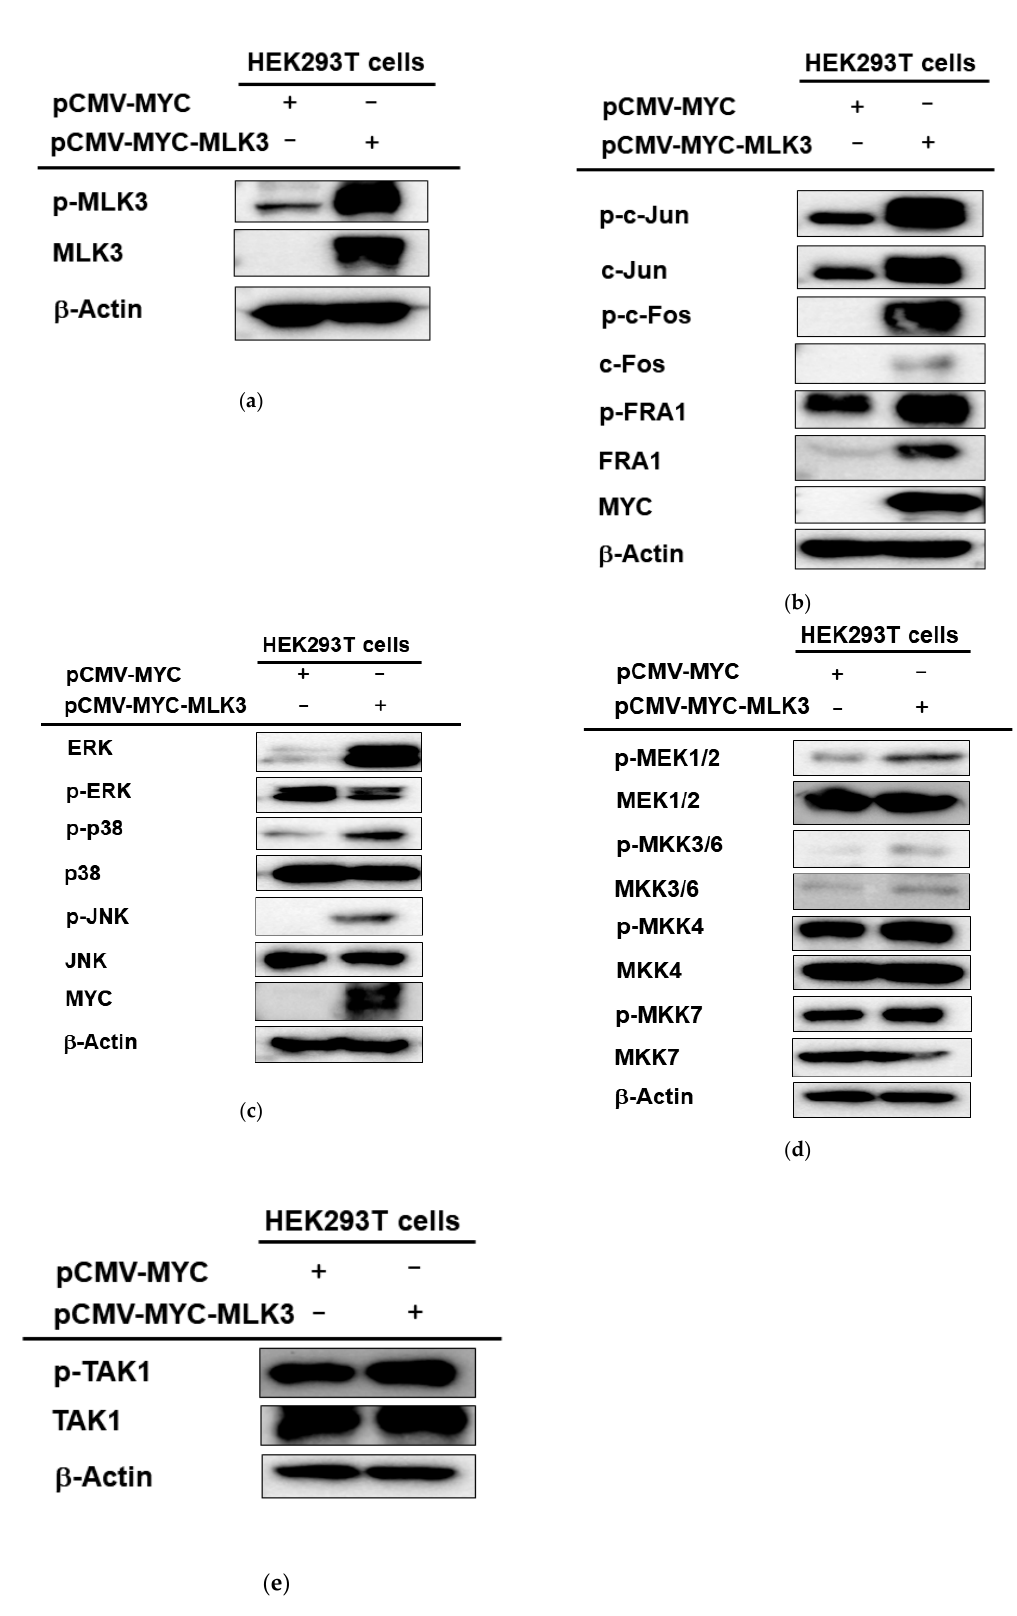
Figure 2. Effect of MLK3 on the phosphorylation of AP-1 subunits, MAPK, and MAPKK. ( a – e ) The phospho- and total forms of MAPK, MAPKK, and AP-1 subunits were detected from whole cell lysates of HEK293 cells transfected with Myc-MLK3 (1 µ g/mL) for 36 h by immunoblotting